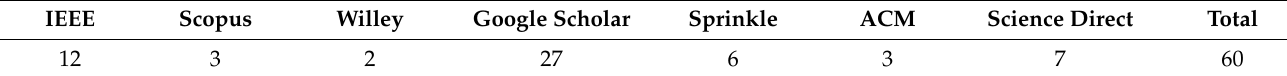
Table 5. Final paper selection.